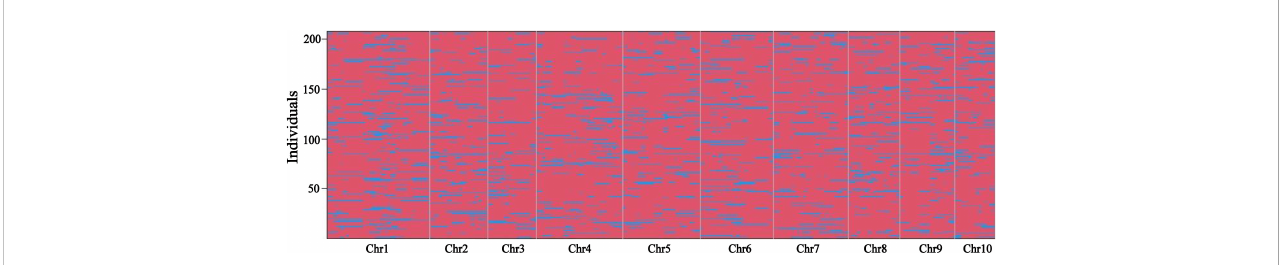
FIGURE 1 Recombination bin map of the TP population. Bin map consists of 1,951 markers. The physical position of markers is based on the B73 RefGen_v4 sequence. Red: PH4CV genotype; Blue: teosinte